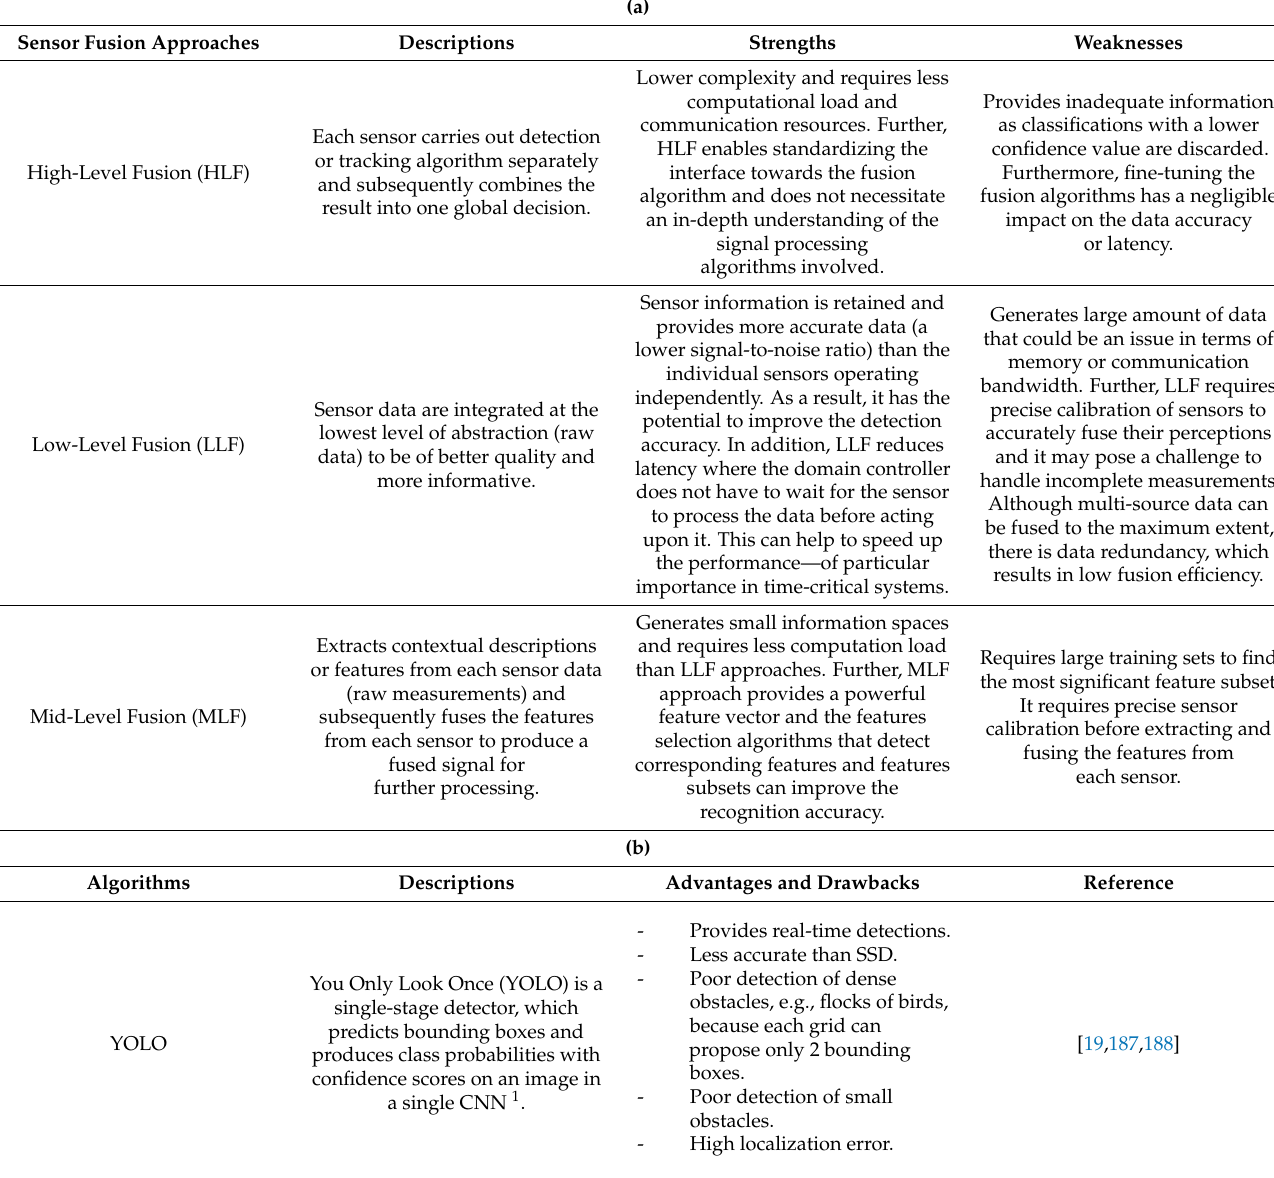
Table 8. ( a ) A comparative overview of the sensor fusion approaches, namely high-level fusion (HLF), low-level fusion (LLF), and mid-level fusion (MLF) [30,180,204–206]. ( b ) Table below summarizes some of the sensor fusion techniques and algorithms that were successfully established in the art for obstacles detection, namely YOLO, SSD, VoxelNet, and PointNet. Further, table below presents a summary of the advantages and drawbacks of each